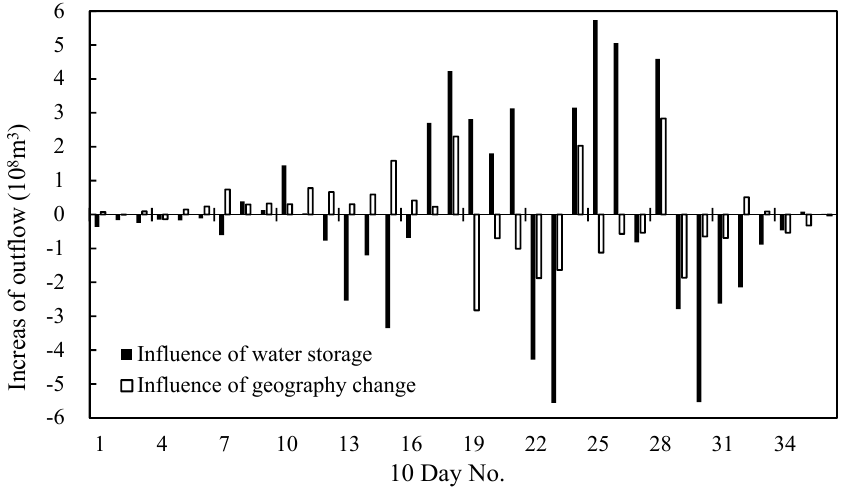
Figure 9. Influences of TGD water storage and geographical change on the outflow of Hukou.